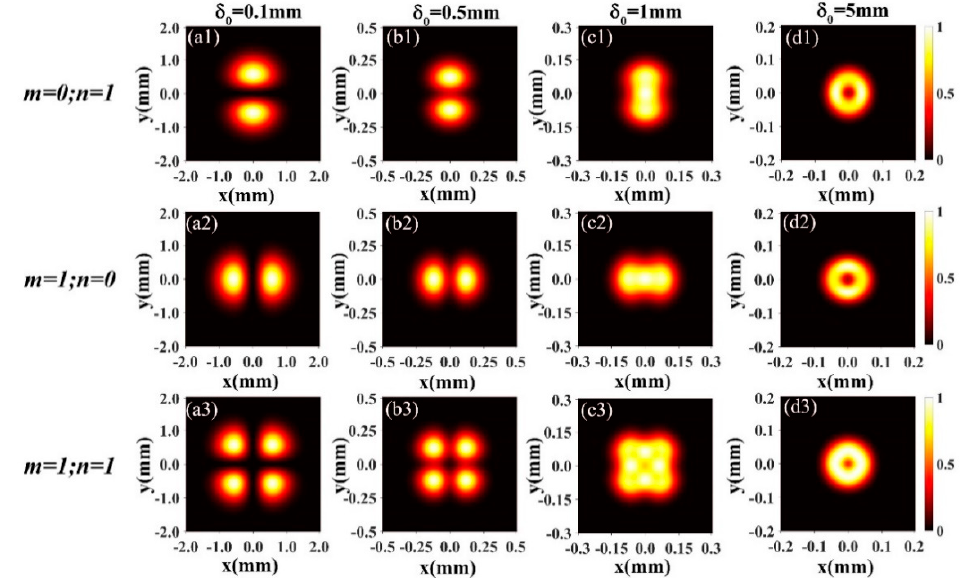
Figure 3. Normalized intensity of a focused HGCSMLG 0l beam at different distances with m = 1, n = 1 and increasing values of the TC.